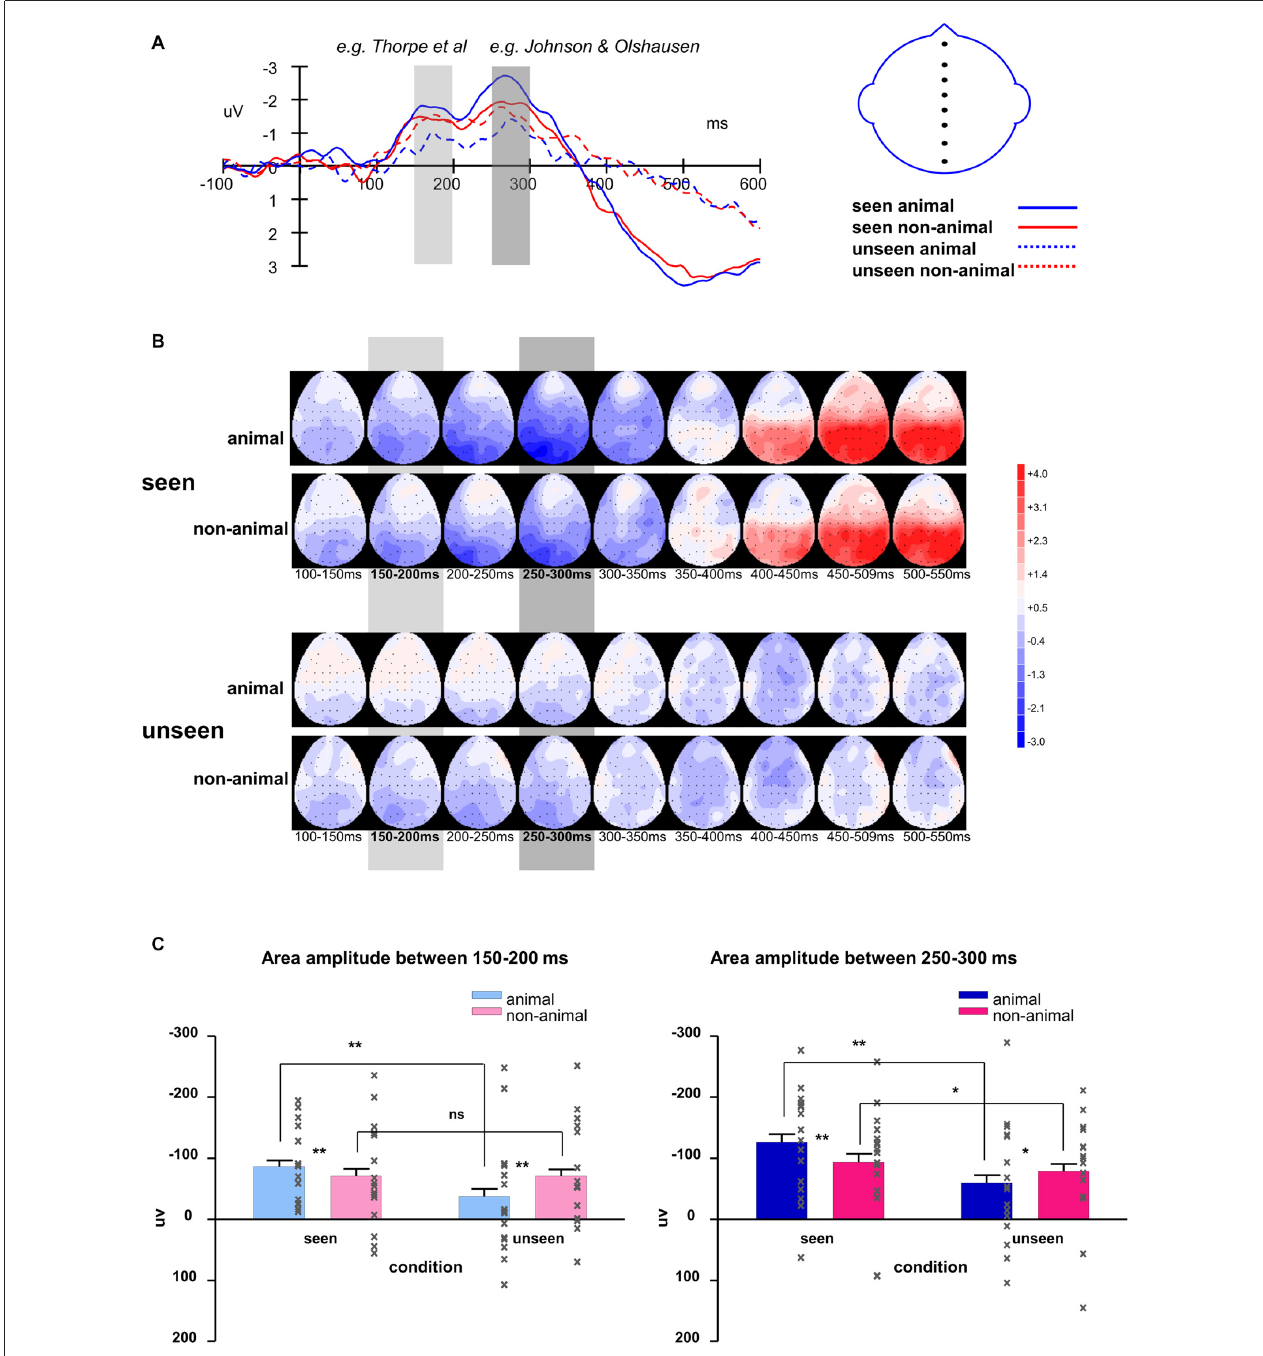
FIGURE 6 | (A) Averaged waveforms of eight midline electrodes and (B) topography for animal and non-animal stimuli in seen and unseen trials; (C) averaged area amplitude between 150–200 ms and 250–300 ms. All error bars represent 1 SEM. Asterisk markers designate statistical significance: ∗ p < 0.05, ∗∗ p <